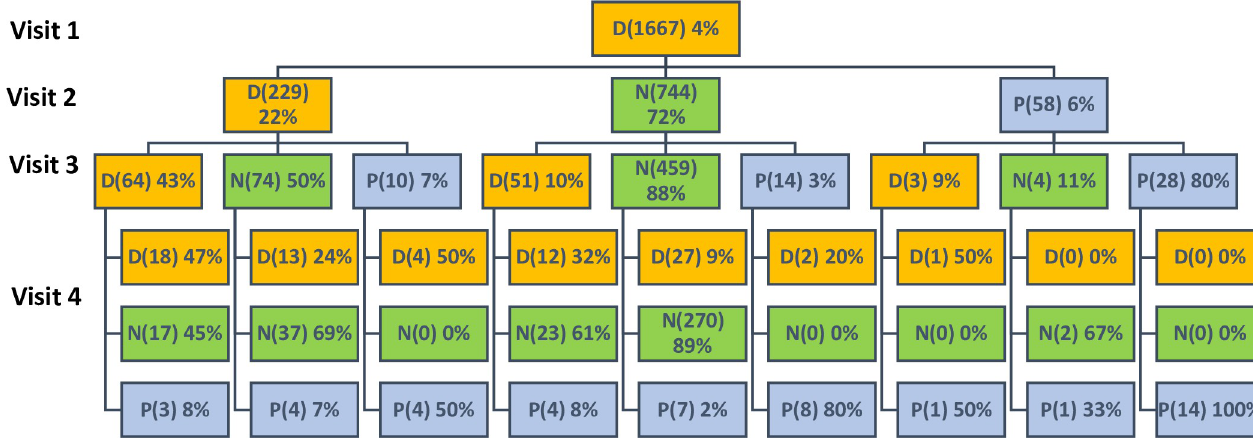
Fig 2. Future HIV EIA results for individuals with indeterminate results at their first visit.